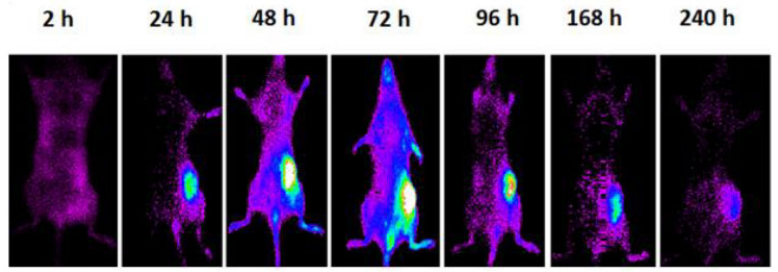
Figure 13. The mouse with a subcutaneous syngeneic tumor was imaged using whole ‐ body optical imaging at various time points (2, 24, 48, 72, 96, 168, and 240 h) after the local administration of 500 μ g of fluorescent PLGA ‐ NPs subcutaneously. Reprinted/adapted with permission from Ref [96].